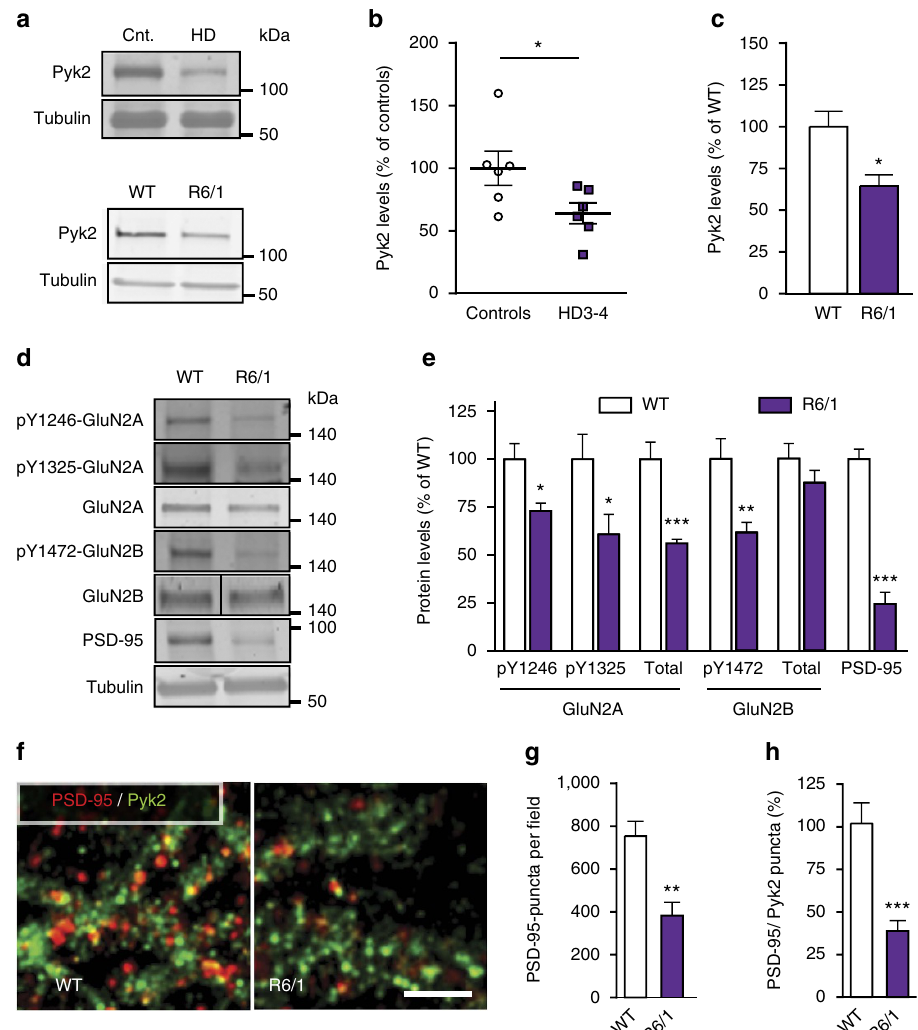
Figure 7 | Hippocampal alterations of Pyk2 and synaptic markers in Huntington’s disease. ( a ) Hippocampal post-mortem samples from human patients grades 3–4 (HD3-4) and controls (Cnt., top panel) and from wild-type (WT) mice and R6/1 transgenic mice (lower panel) were analysed by immunoblotting for Pyk2 and a -tubulin as a loading control. Molecular weight marker positions are indicated in kDa. ( b ) Densitometric quantification of results as in a , for human samples expressed as a percentage of the mean in controls ( n ¼ 6 per group, Student’s t -test, t 10 ¼ 2.25, P o 0.05). ( c ) Quantification of results as in a for WT and R6/1 mice (percentage of WT mean, n ¼ 4–6 mice per group, Student’s t -test, t 8 ¼ 3.23, P ¼ 0.012). ( d ) Immunoblotting for phosphorylated forms and total GluN2A and GluN2B, and PSD-95 in hippocampus of WT and R6/1 mice. ( e ) Quantification of results as in d (percentage of WT mean), Student’s t -test, pY1246-GluN2A, t 9 ¼ 3.10, P ¼ 0.013, pY1325-GluN2A, t 9 ¼ 2.37, P ¼ 0.04, GluN2A, t 9 ¼ 5.21, P ¼ 0.0006, pY1472-GluN2B, t 8 ¼ 3.64, P ¼ 0.0066, GluN2B, t 8 ¼ 1.22, P ¼ 0.26, PSD-95, t 9 ¼ 9.18, P o 10 (cid:2) 4 . ( f ) Confocal images of the stratum radiatum